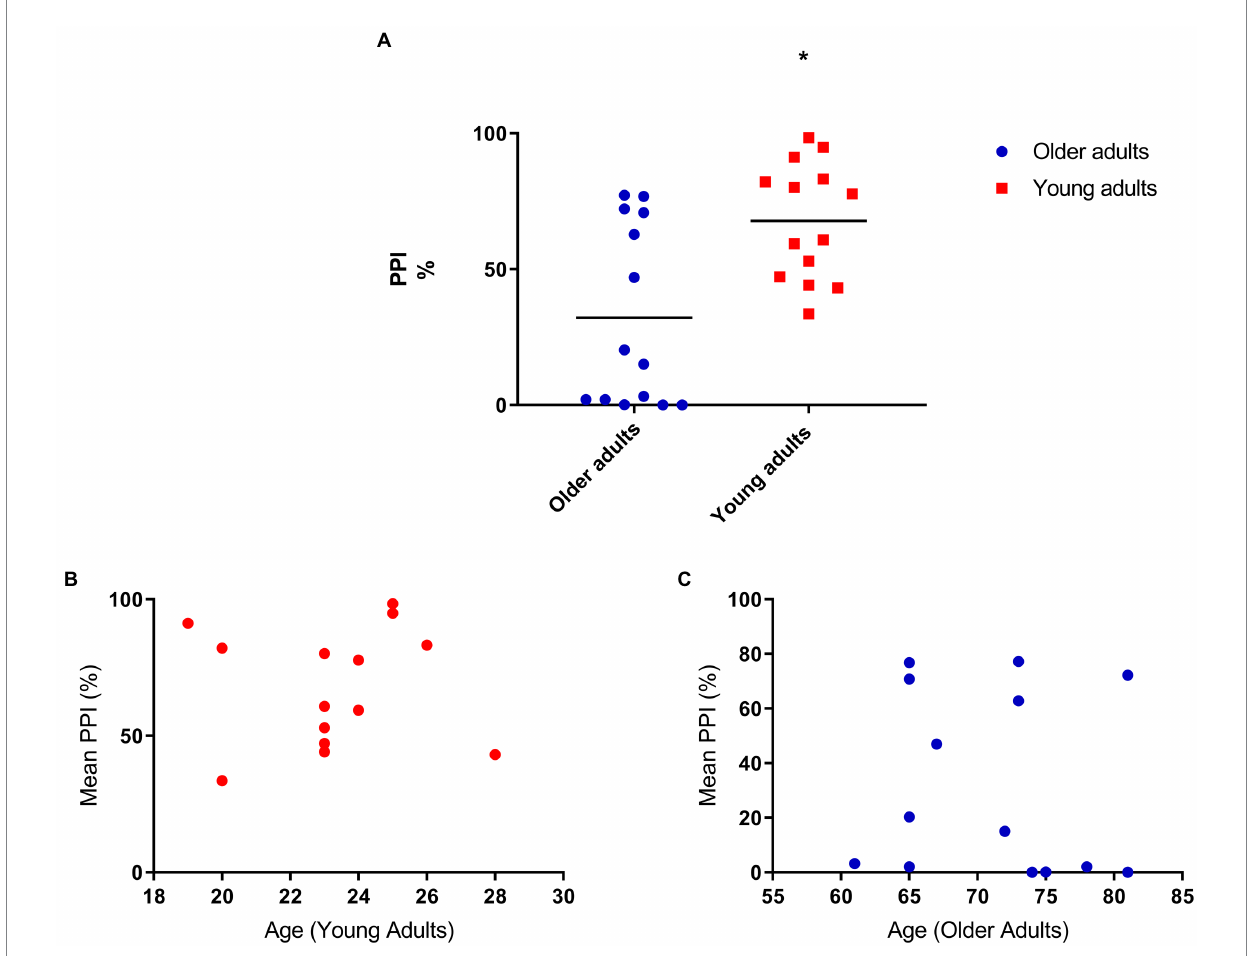
FIGURE 2 (A) Older adults have less prepulse inhibition compared to young adults. Mean percent inhibition: 32.5 (older adults), 67.76 (young adults). ANOVA corrected for startle F [1,25] = 7.44 p = 0.01; (B) Prepulse inhibition does not correlate with age (young adults; N = 14), r = 0.01, p = 0.1; (C) Prepulse inhibition does not correlate with age (older adults; N = 14), r = − 0.08, p =